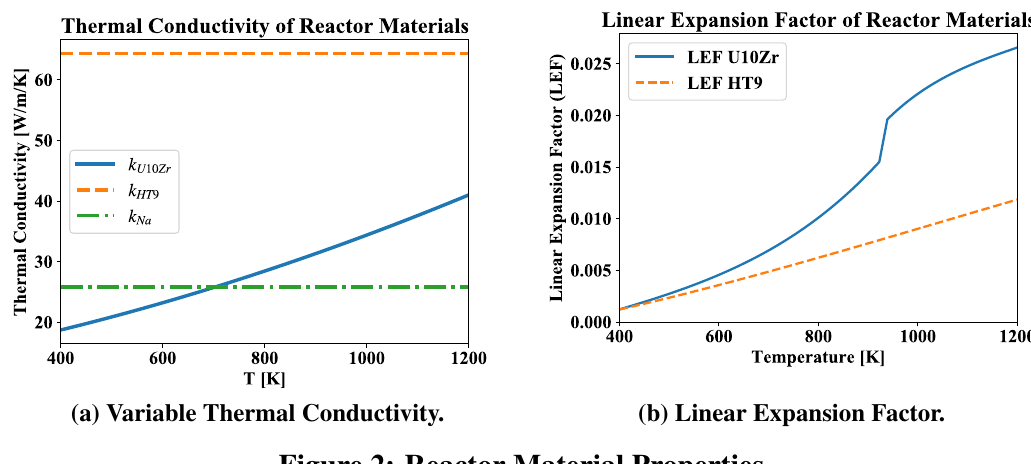
Figure 2: Reactor Material